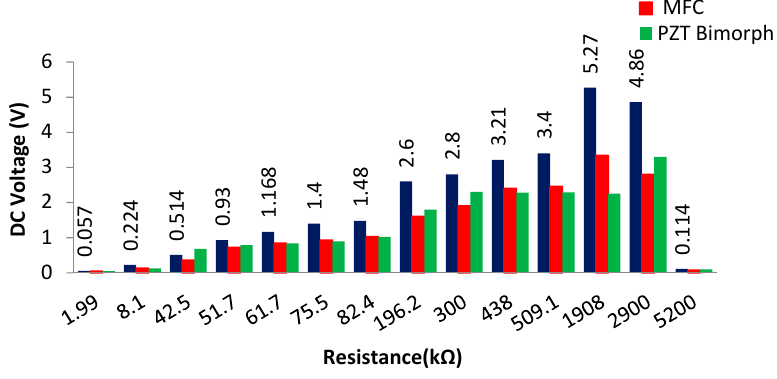
Figure 10. The generated voltage at a frequency of 30 Hz of various harvesters.